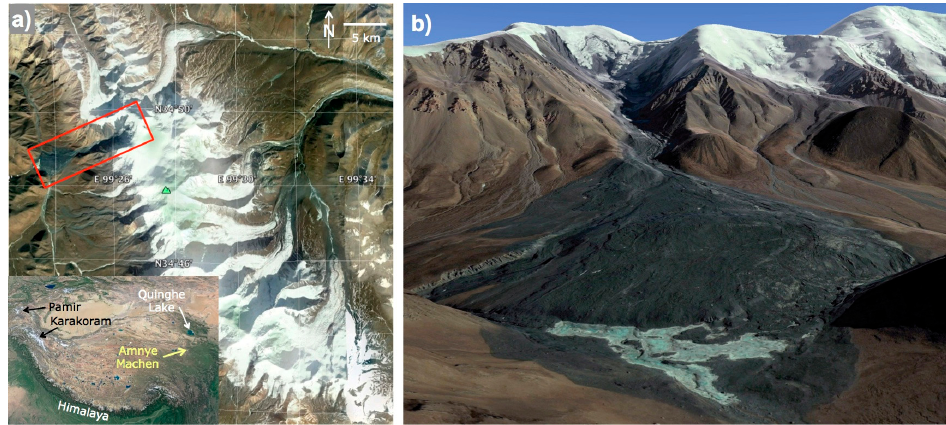
Figure 1. ( a ) Location of the Amney Machen mountain range in north-eastern Tibet, China. The collapsed glacier is marked with a red square. The location of the study region is marked in the inset with a yellow arrow. Image sources: Screenshots from Google Earth. ( b ) Oblique perspective view of the collapsed glacier as seen on a Quickbird image acquired on 13.1.2008, a few months after the second collapse. The steep and partly already glacier-free rock walls can be seen in the background. The extent of the 2004 collapse is still visible in the foreground, the deposit from the 2007 collapse can be seen on top of it. Image source: Screenshot from Google Earth.